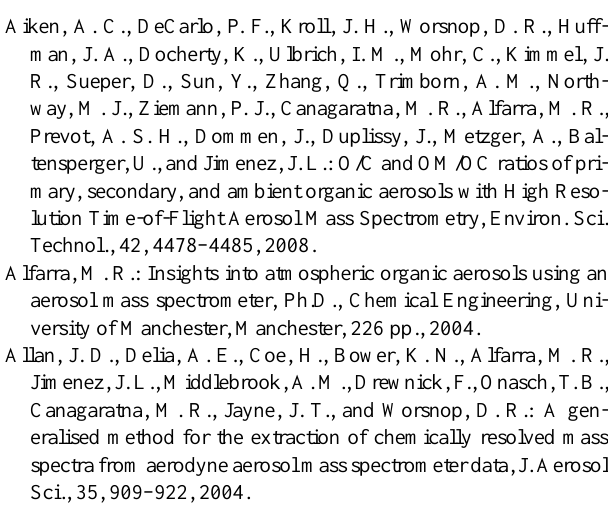
a SO 2 − a NH + b EC NO x NO 4 4